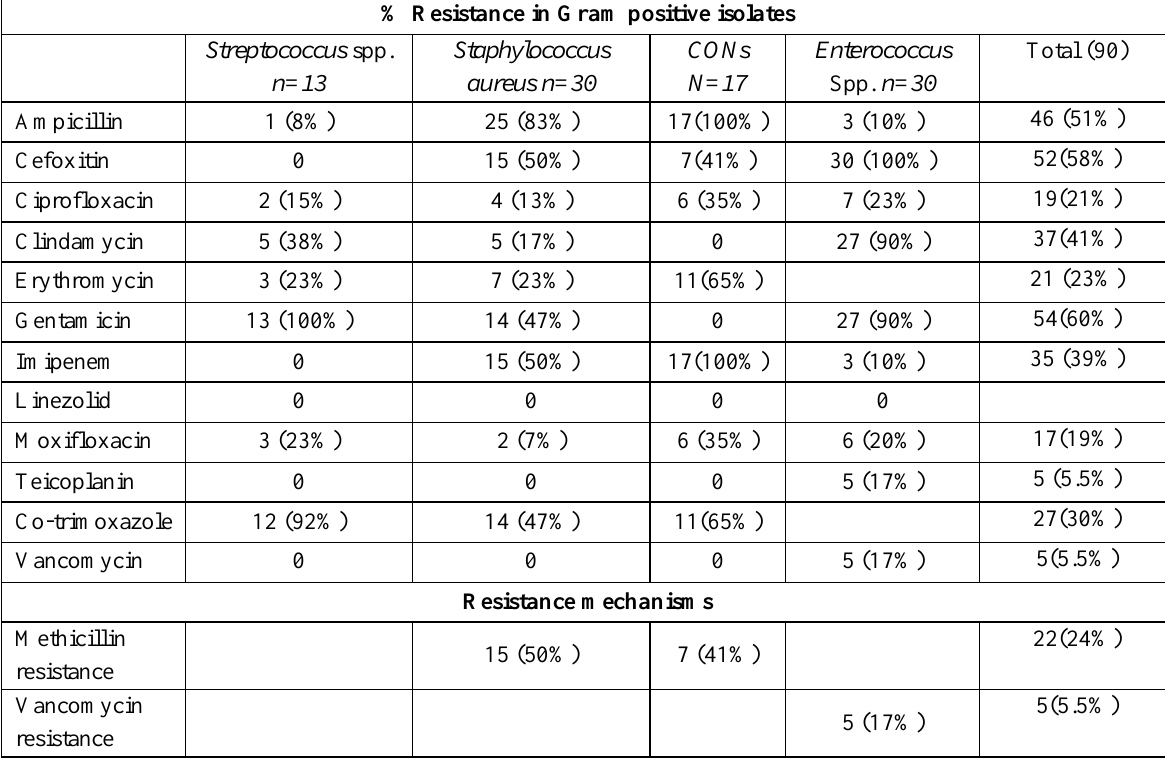
Table 4 . Antimicrobial susceptibility and resistance pattern of Gram positive isolates